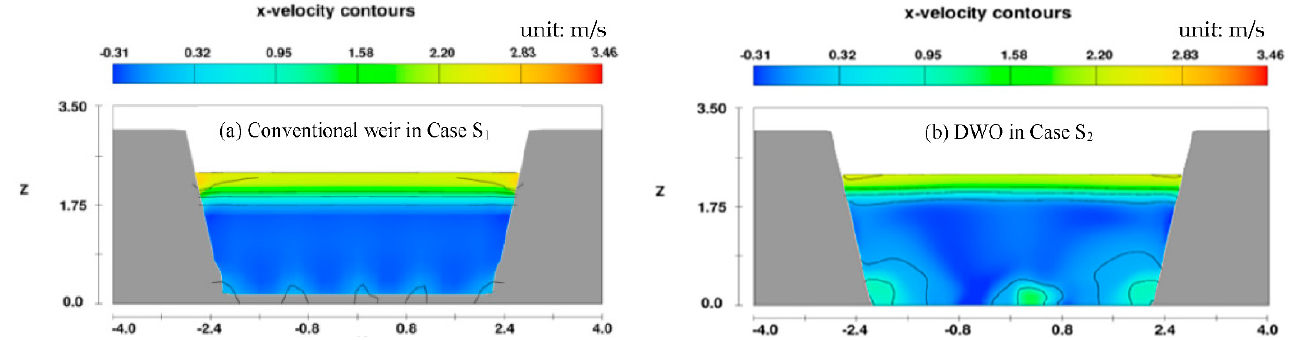
Figure 11. Velocity contours of the cross − section (X/L = 0.21, upstream). L is the length of the transition reach, and X is the distance of cross − section selected away from the inlet. ( a ) There is mainly upper overflow of the weir crest without bottom flow in S1, and the velocity is about 2.2 to 2.8 m/s. The bottom circumfluence could be affected by roughening blocks. ( b ) The bottom flow velocities passing through three orifices are all about 0.6 to 1.0 m/s, and the upper overflow velocity is reduced to 1.2 to 2.3 m/s. The velocities of the weir flow and orifice flow are both suitable for fish migration in S2. In the figure, x, y, and z denote the longitude, transverse, and vertical coordinates (unit: m). The x − velocity is the longitudinal flow velocity (unit: m/s).